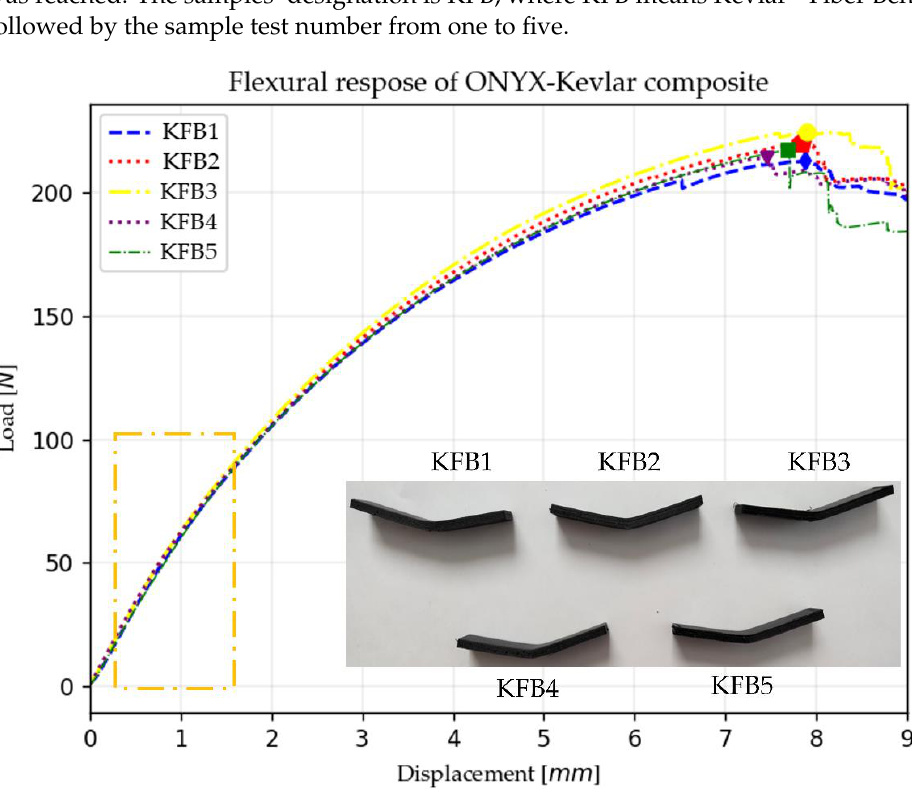
Figure 6. Bending test load – displacement curves, linear zone considered for flexural modulus, marked as a rectangle, and samples after failure (KFB1, KFB2, KFB3, KFB4 and KFB5 images shown are the actual samples for bending